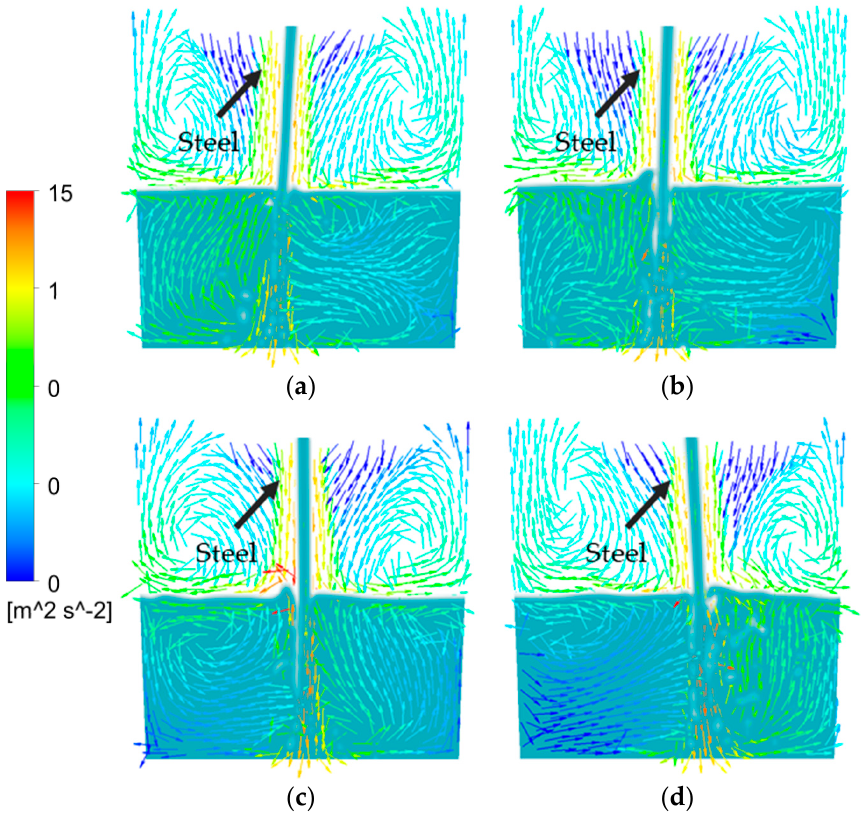
Figure 8. Velocity vector diagram of the ladle at di ff erent tapping angles of the converter: ( a ) 90°; ( b ) 95°; ( c ) 100°; ( d ) 105°.